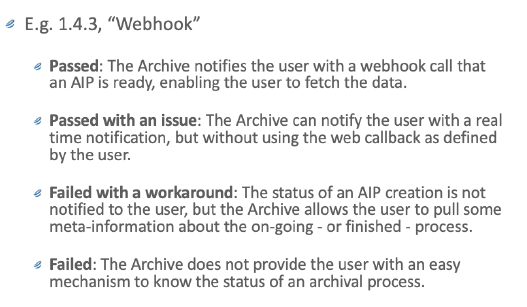
Fig. 10. Example of a test assessment in Fig. 9. Continuous Testing Environment for ARCHIVER’s testing activities.